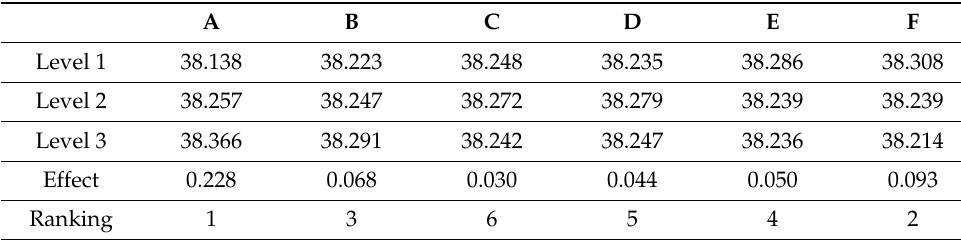
The response table of far-infrared emissivity is presented in Table 16. Table 16. The response table of the far-infrared